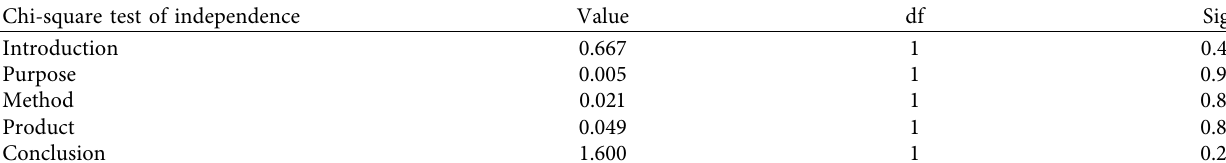
Table 2: Results of chi-square test.